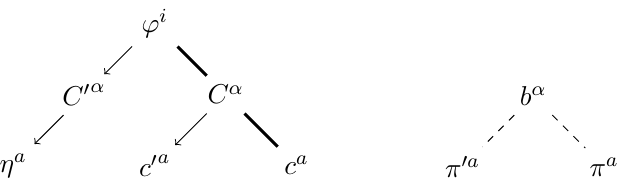
Figure 1 . The pyramid of ghosts fields in the first-stage reducible case [4]. The fields linked by a thick line constitute the minimal BV sector; an arrow a → b indicates that the field b (along with its partner in a trivial pair) is introduced to fix the gauge freedom of a . The second pyramid shows the partners of the non-minimal fields of the first pyramid.